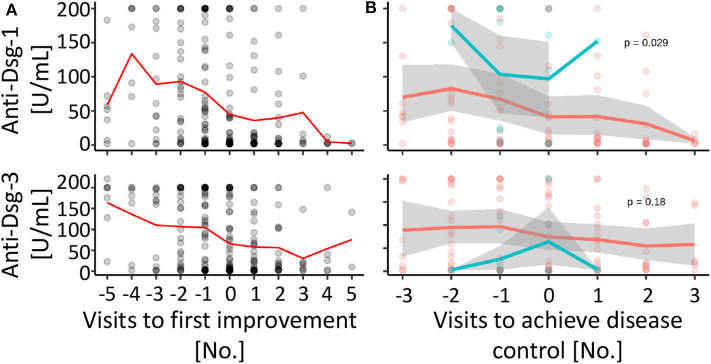
Anti-desmoglein serum antibodies decline over time, but are not associated with therapy changes. (A) The individual anti-desmoglein-1 and−3 serum concentrations (gray circles, overlapping values with a darker color intensity) and mean values (red line) were displayed for the respective visit [0 = first visit with clinical improvement, numbers of the visits before (negative) and after (positive) improvement]. (B) The autoantibody concentrations compared between subgroups with more (>4, red) or less (≤4, blue) than average therapy changes shown as individual values (circles) and mean (line) over time to achieve disease control (visit 0 = first visit with a severity score of 1 or 0). Gray area: 95% confidence interval. P-values calculated by repeated ANOVA.